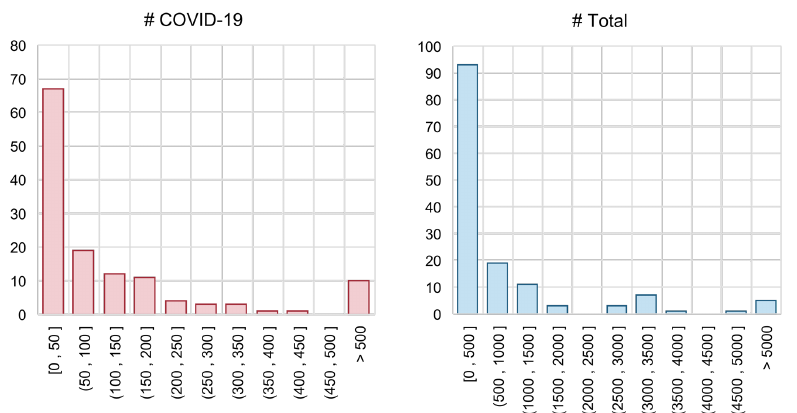
Figure 9. Histograms of the testing set size. “# COVID-19” = number of samples labelled as COVID-19 positive; “# Total” = total number of sample.